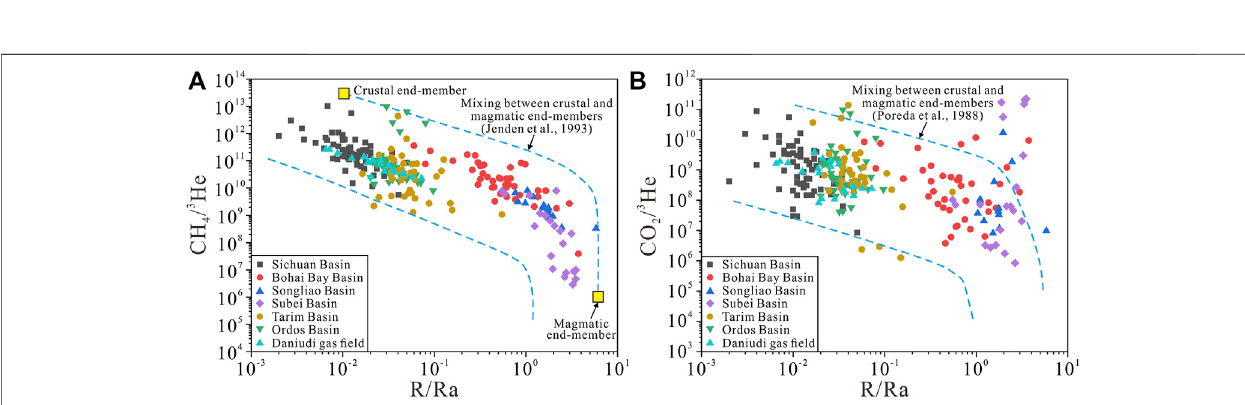
Frontiers in Earth Science |